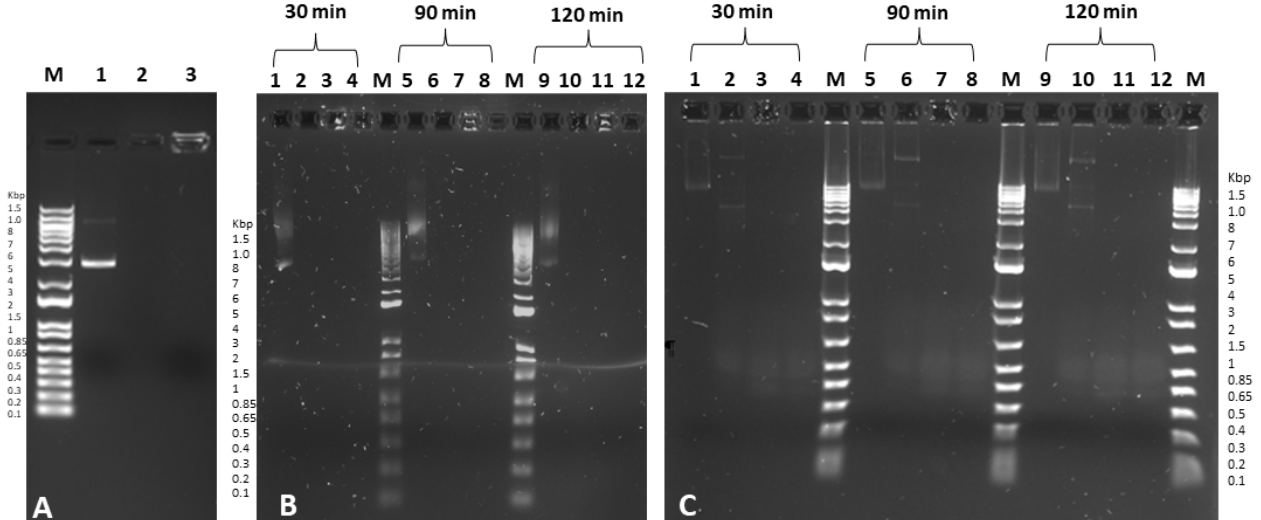
Figure 2. ( A ) Agarose retardation assay of DNA-loaded hPECs. Lane M: DNA marker 1Kb; Lane 1: